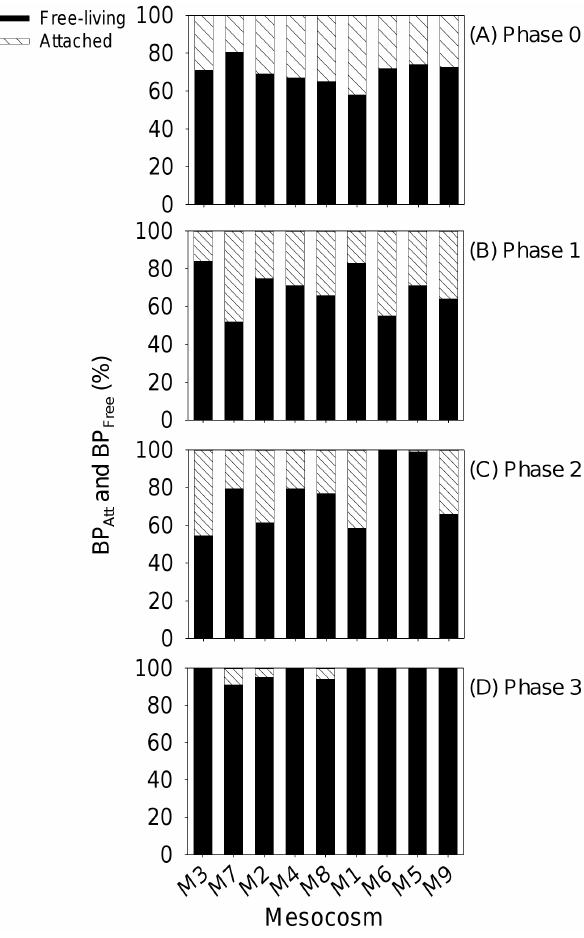
Fig. 3. Percentage of attached (line bars) and free-living bacterial production (solid bars) in phase 0 (A) , phase 1 (B) , phase 2 (C) and phase 3 (D)